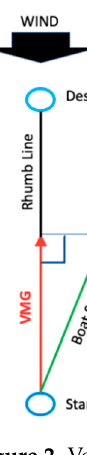
Figure 2. Velocity Made Good. Note: VMG = Velocity Made Good.